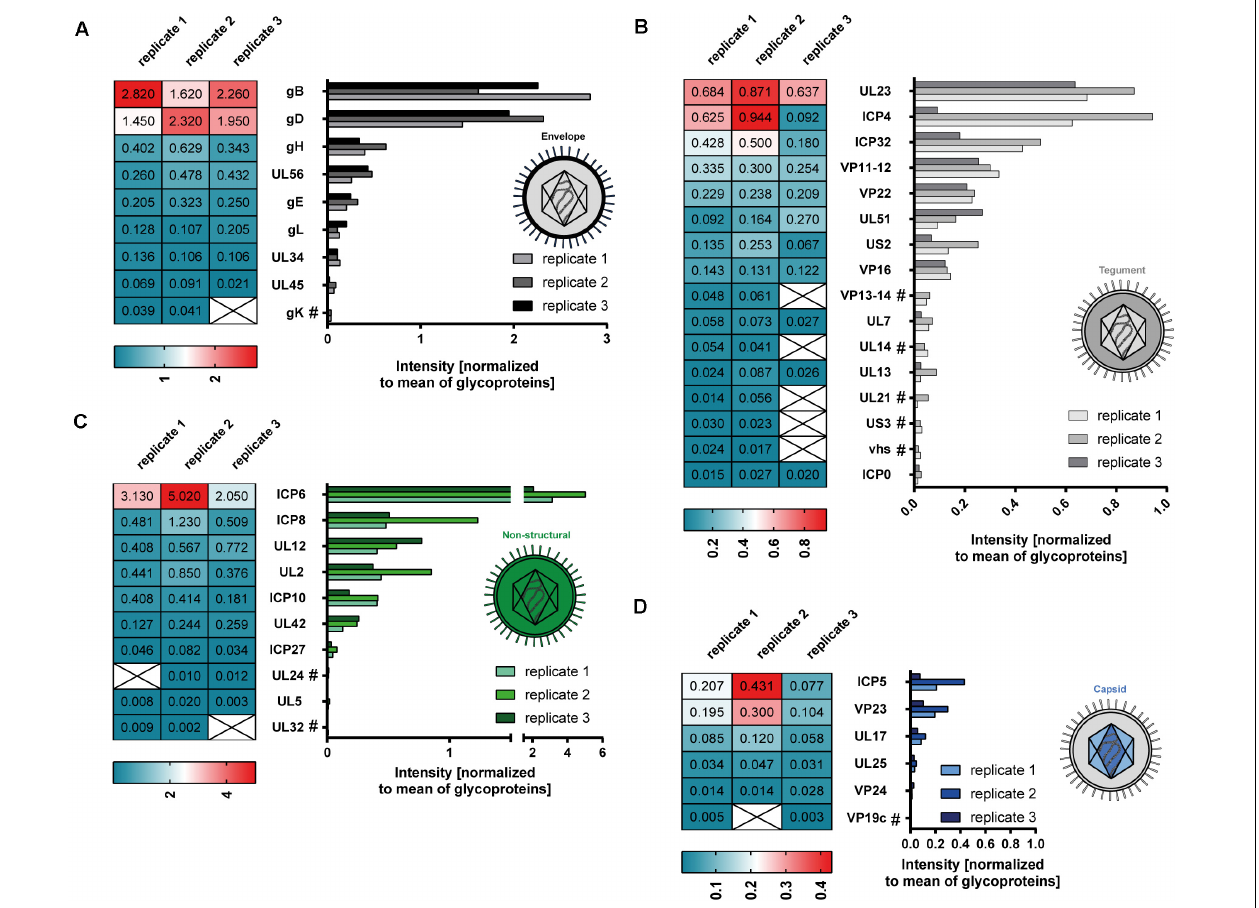
FIGURE 4 | Mass spectrometry-based analysis of HSV-1-derived L-particles from mDCs. HSV–1-derived L-particles were isolated from supernatants of infected mDCs and used for subsequent mass spectrometric analysis. The results of all three replicates are shown as individual intensities normalized to the mean intensity of all glycoproteins in the respective sample (heat map, graph). Proteins are grouped according to their annotation as envelope (A) , tegument (B) , non-structural (C) or capsid proteins (D) . Proteins detected in two out of three replicates are marked with